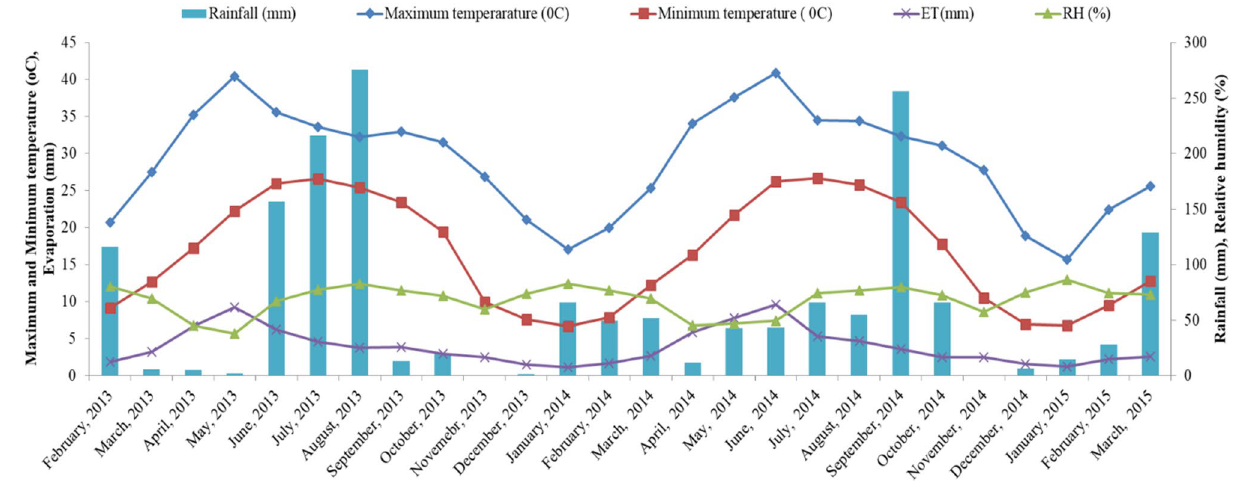
Figure 3. Maximum and minimum temperatures, evaporation rates, and relative humidities of Karnal (Haryana State, India) during the two-year experimentation weights of these samples were recorded. Fibre percentage was estimated using the rapipol extraction method and calculated as per the method explained in Thangavelu and Rao (1982) 50 .